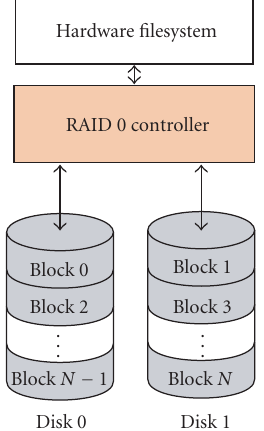
Figure 12: Hardware Filesystem connected to the RAID 0 Con- troller which stripes the data blocks across two